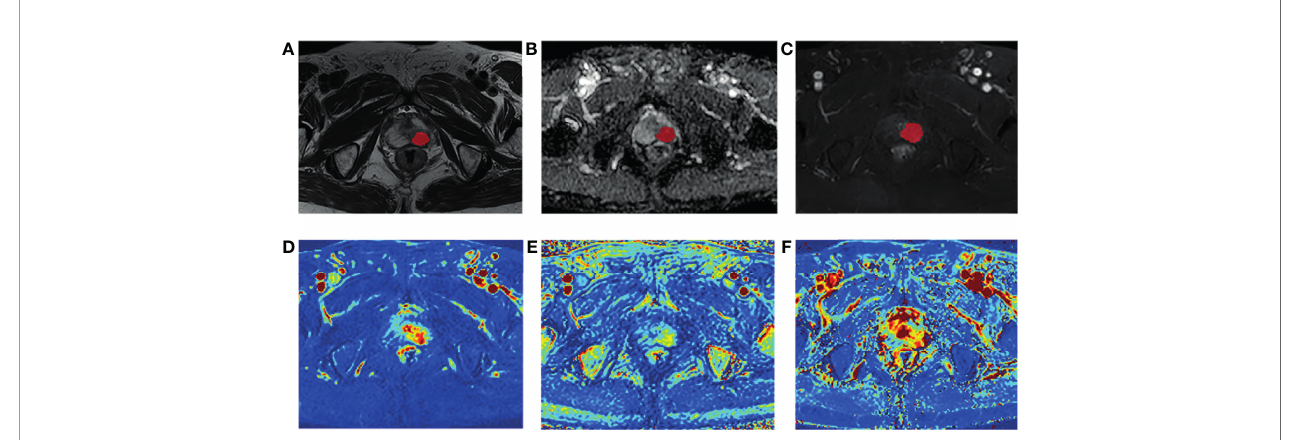
FIGURE 2 | A 80-year-old man diagnosed with csPCa in TZ (PSA,59.90 ng/mL; biopsy GS, 3 + 4 = 7). Example segmentations (red masks) of the tumor overlaid on on axial T2-weighted imaging (T2WI) (A) , apparent diffusion coef fi cient (ADC) map (B) , and dynamic contrast-enhanced MRI (DCE-MRI) (C) . The ROIs were selected based on the enhanced T1WI and then matched to Ktrans map (D) , Kep map (E) , and Ve map (F)